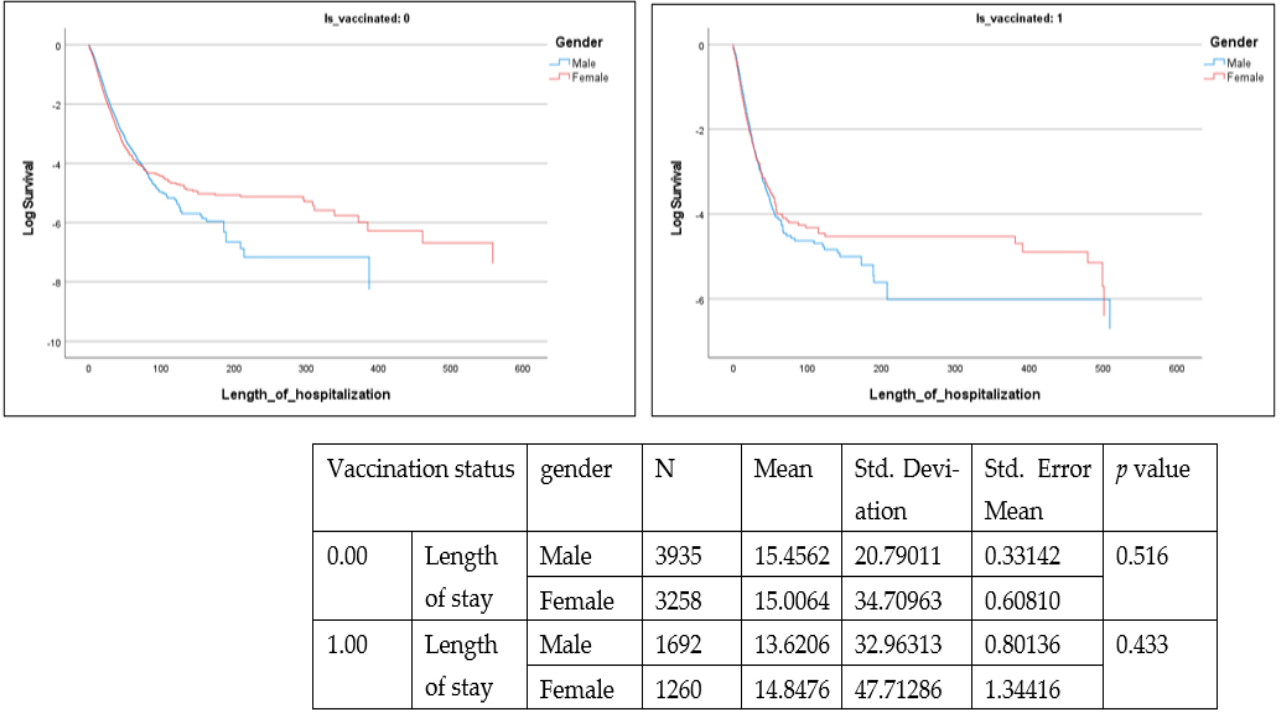
Figure 5. Time from positive diagnosis to hospital admittance ((Is vaccinated 1 = vaccinated with at least one dose).